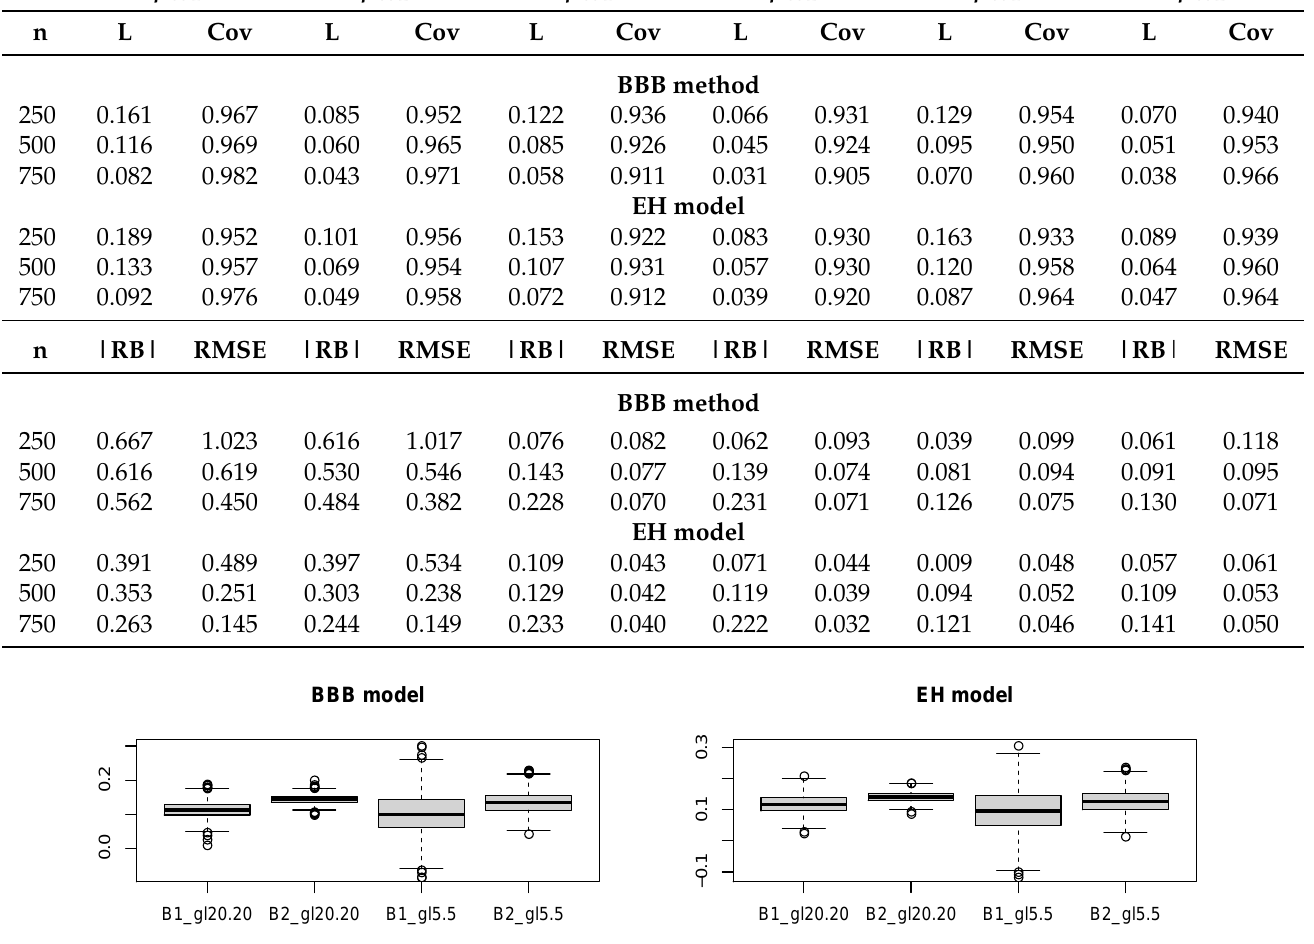
Figure 1. Boxplot for ˆ β W 1 and ˆ β W 2 in SRSS in the BBB model ( left ) and EH model ( right )